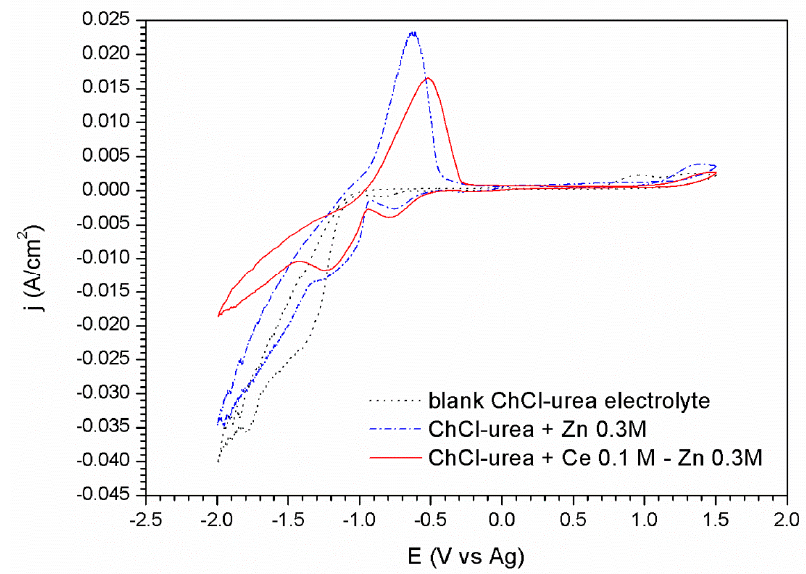
Figure 2. Voltammograms corresponding to the steel substrate: in the blank ionic liquid, with 0.3 M of Zn salt, and with 0.3 M of Zn salt and 0.1 M of Cerium salt.